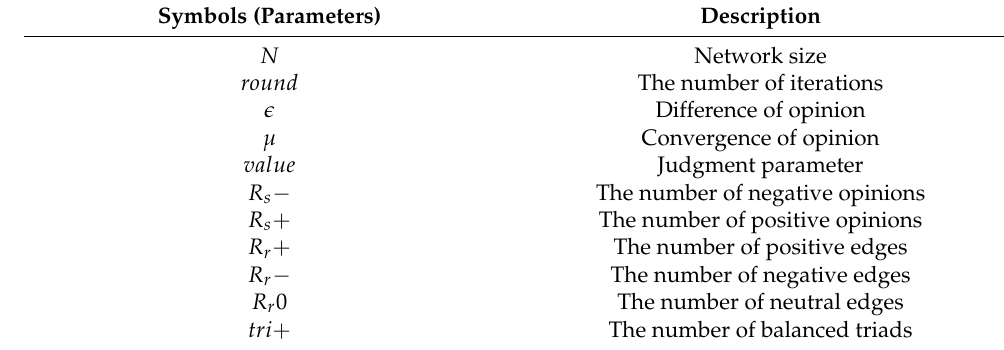
Table 1. Initialization